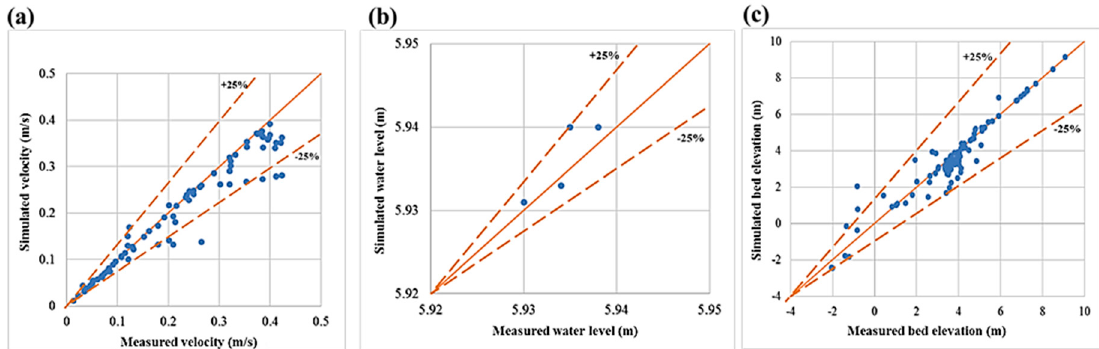
Figure 12. Comparison between measured and simulated data used in the model validation ( a ) velocity; ( b ) water level; ( c ) bed averaged velocity; ( b ) water level; ( c ) bed elevation. Table 6. Comparisons between measured and simulated average flow velocity.